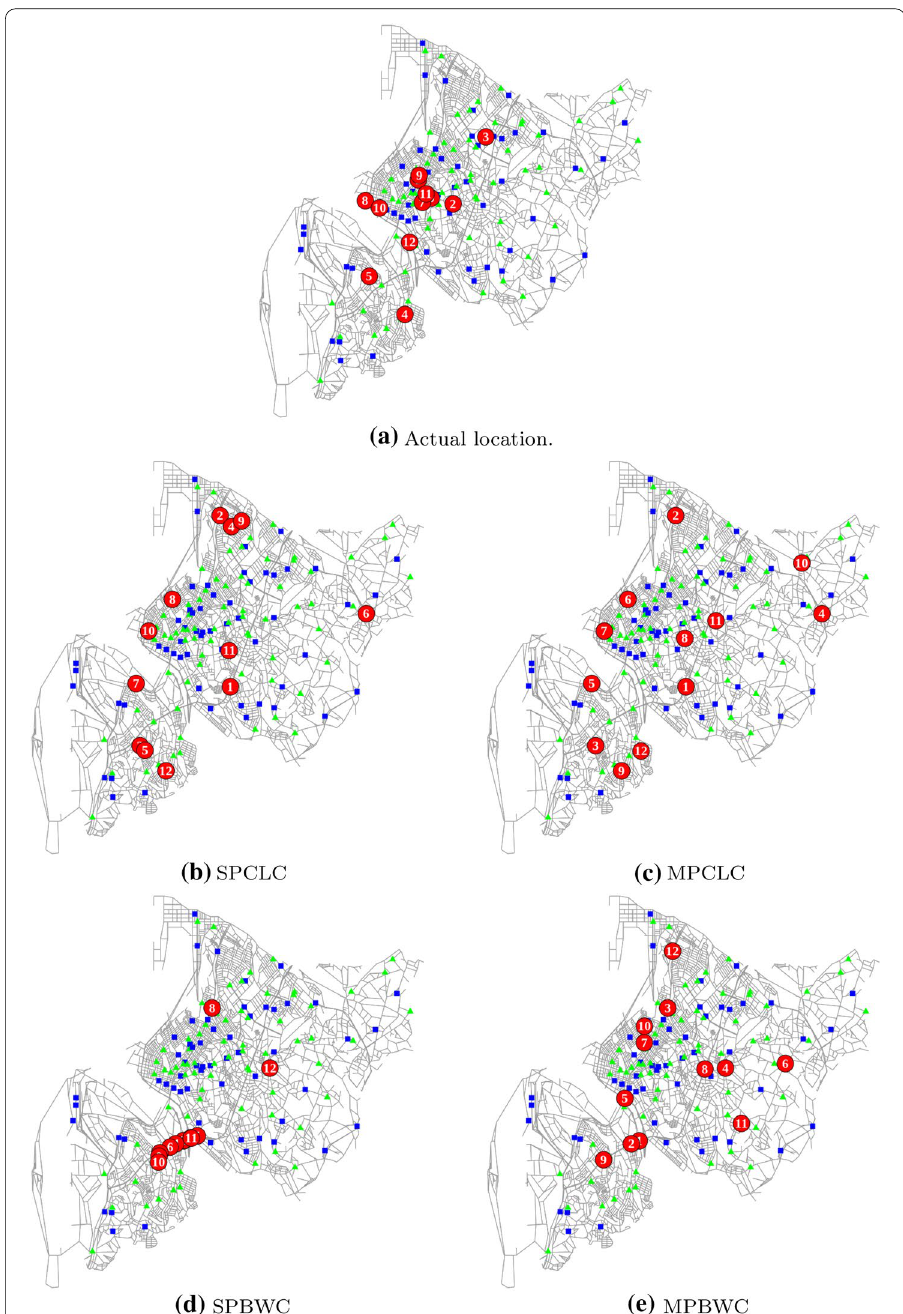
Fig. 4 Predicted locations of g1 stores (Naha): Red nodes are predicted locations of stores of g1 where the numbers indicate the opened order; green and blue nodes are the locations of stores of already present chains, g2 (green) and g3